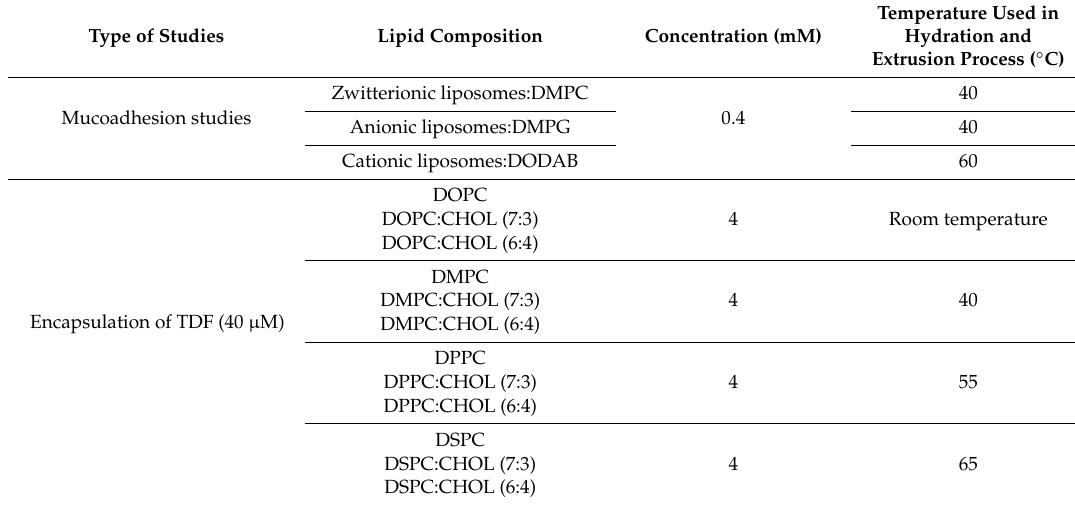
Lipid composition of the di ff erent liposomal formulations used throughout the work as well as the concentration and hydration and extrusion temperature used for their